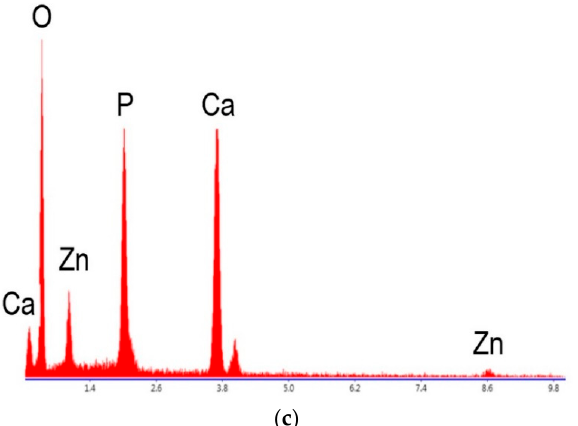
Figure 2. SEM/EDS images of the ZH powder: ( a ) SEM image of the powder; ( b ) EDS analysis of point 1; EDS analysis of point 2.